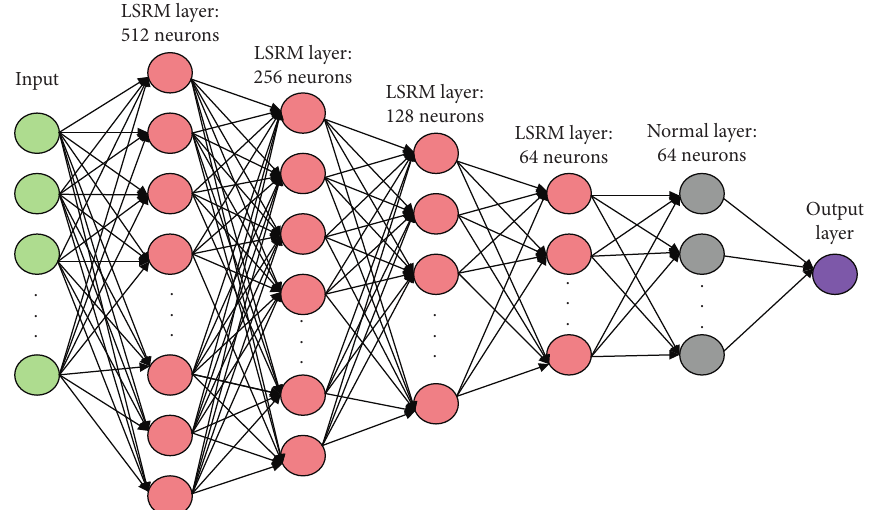
Figure 3: LSTM prediction model of the PV station’s generation.